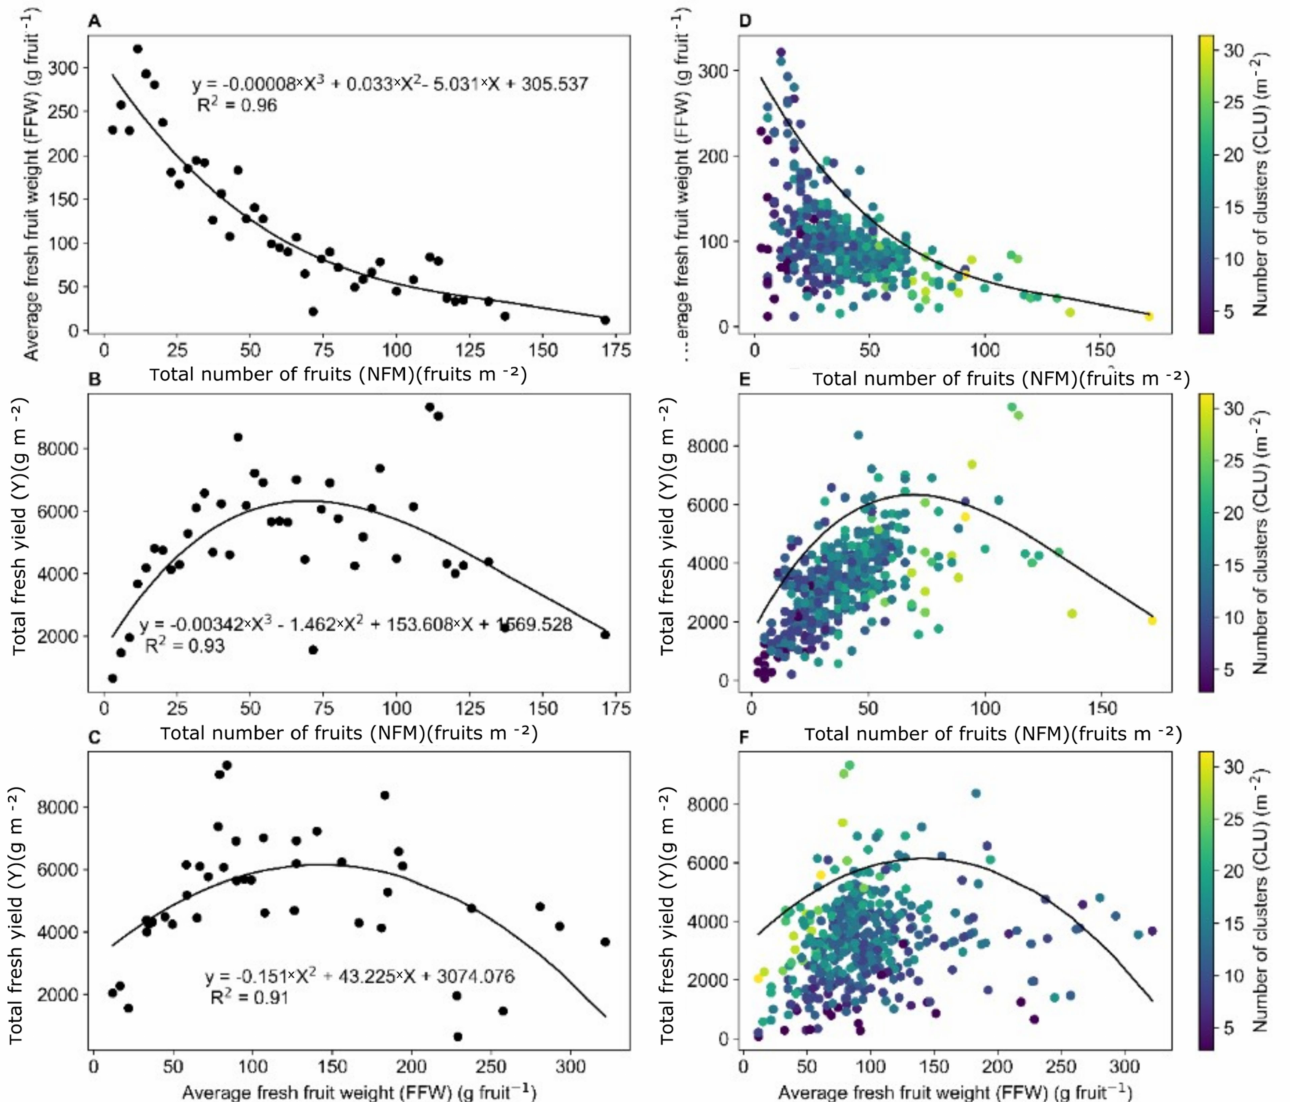
Figure 2. Tomato yield components. Left ( A – C ): Potential principal yield components; the models, fixed to the maximum values reached for each case, show a diminishing return for both yield components over yield. Right ( D – F ): Principal yield components of all the plants evaluated, colored by the cluster number per plant m − 2 (CLU), with the fixed